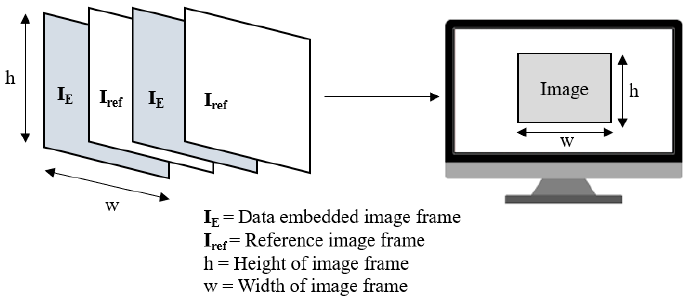
Figure 2. Sequential image frames of the displayed by the screen.